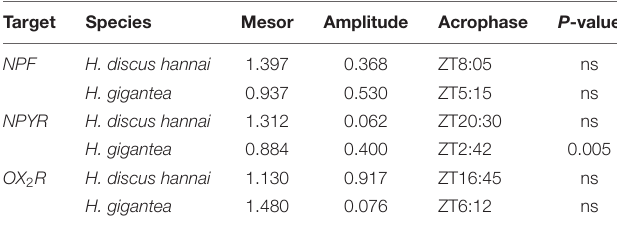
TABLE 4 | Cosinor analysis results obtained based on the relative expression levels of feeding-related